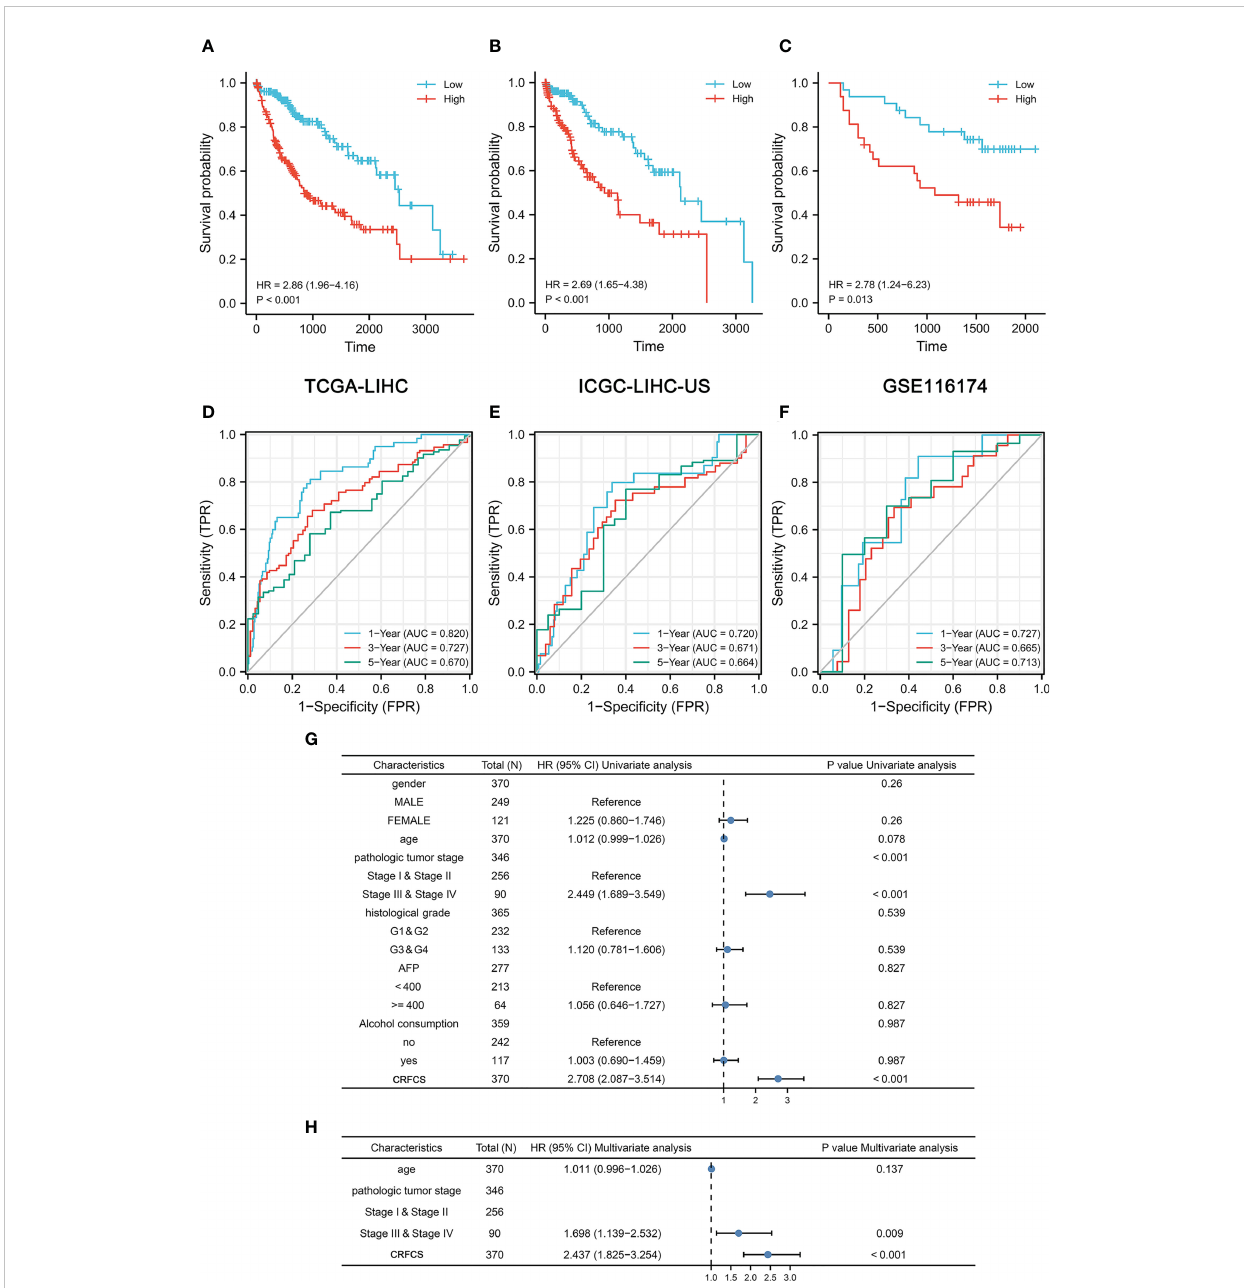
FIGURE 3 Prognosis prediction of CRFCS. (A, C) Kaplan-Meier curves of CRFCS subgroups for the training cohort TCGA-LIHC (A) , the external validation cohorts ICGC-LIHC-US (B) , and GSE116174 (C) . (D – F) AUC curves for the prediction of overall survival (OS) by CRFCS in samples of TCGA-LIHC (D) , ICGC-LIHC-US (E) , and GSE116174 (F) . (G, H) Univariate (G) and multivariate analysis (H) of